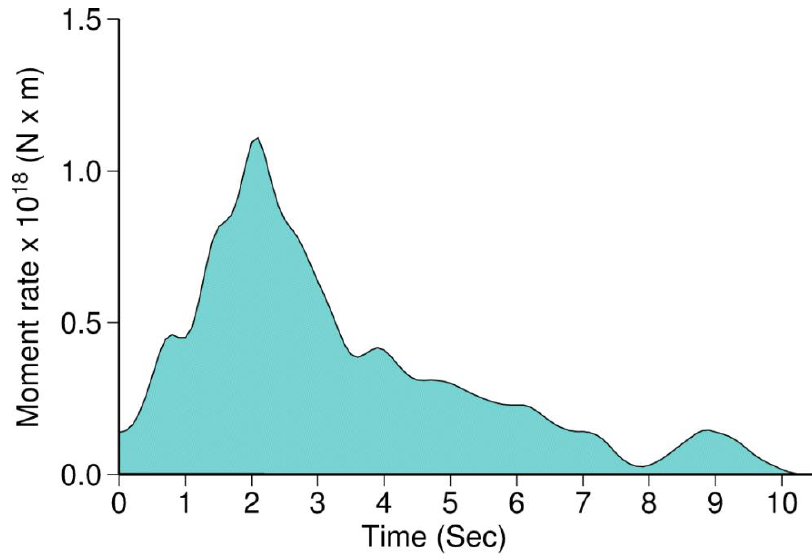
Figure 7. Moment rate function of the 3 March 2021 earthquake of M w = 6.3.